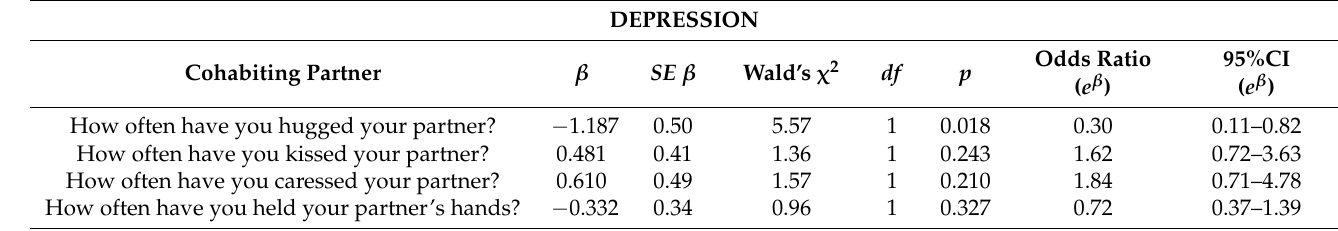
Table 3. Log binomial regression between the prevalence of the four physical positive touch types and each of the three mental health outcomes (depression, anxiety, and